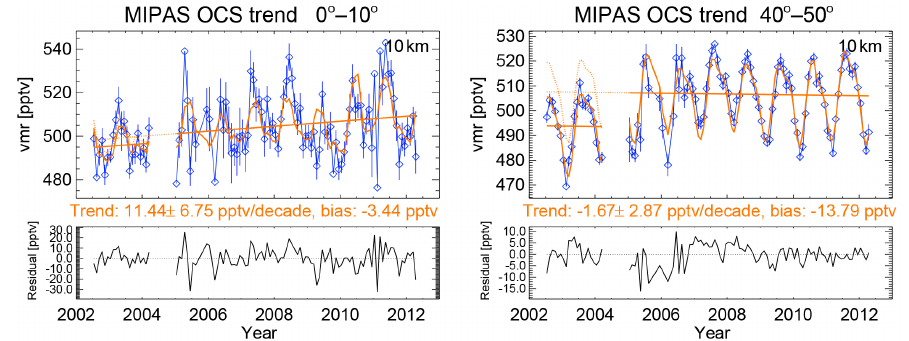
Figure 13. Trend analysis of MIPAS OCS measured at 10km altitude in the latitude bands 0–10 ◦ N (left) and 40–50 ◦ N (right). The upper panels show monthly means of measured and fitted OCS (blue and red curves) and fitted linear trends (red lines). The lower panels show the